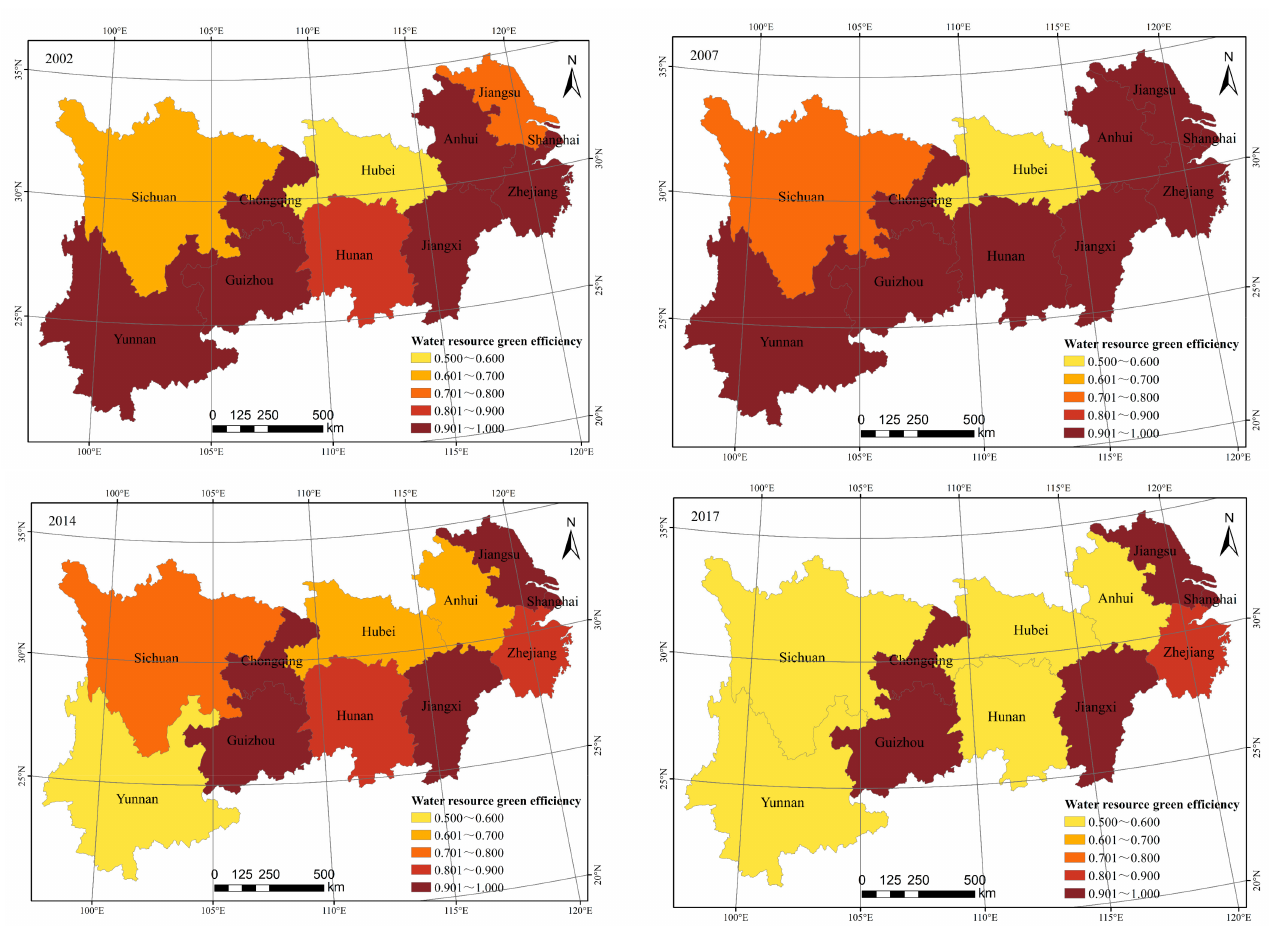
Figure 6. Spatial-temporal evolution of green efficiency of water resources in the Yangtze River Economic